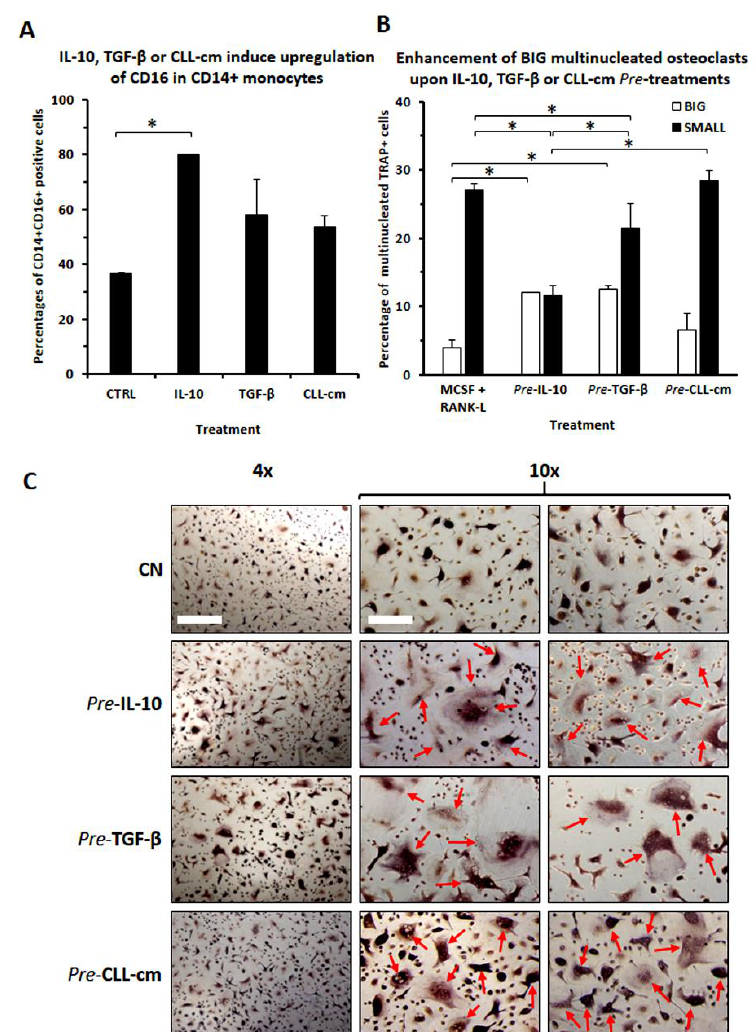
Figure 6. Effects of cytokines exposure on CD16 expression and on osteoclast differentiation in healthy monocytes. ( A ) Monocytes pre-stimulated with cytokines potentially released within the microenvironment, such as IL-10 and TGF β , or with CLL-cm, showed up-regulation of CD16 expression after 48 h of treatment, as determined by cyto-fluorographic analysis. ( B ) CD16 up-regulation, due to cytokine pre-treatment, appeared further paralleled by an increase in multinucleated BIG osteoclast formation. Histograms depict the mean ± SD of monocytes treated with CLL-cm from 3 CLL cases repeated in 2 separate experiments. ( C ) Monocytes pre-stimulated with IL-10, TGF β and CLL-cm gave rise to a higher number of frankly multinucleated TRAP+ osteoclasts (arrows) as compared to MCSF+RANKL treatment only (CN), as depicted in images from a representative experiment. Bars correspond to 60 and 25 µm for 4X and 10X images, respectively. Statistical significance was determined by using ANOVA and Tukey’s post hoc test.